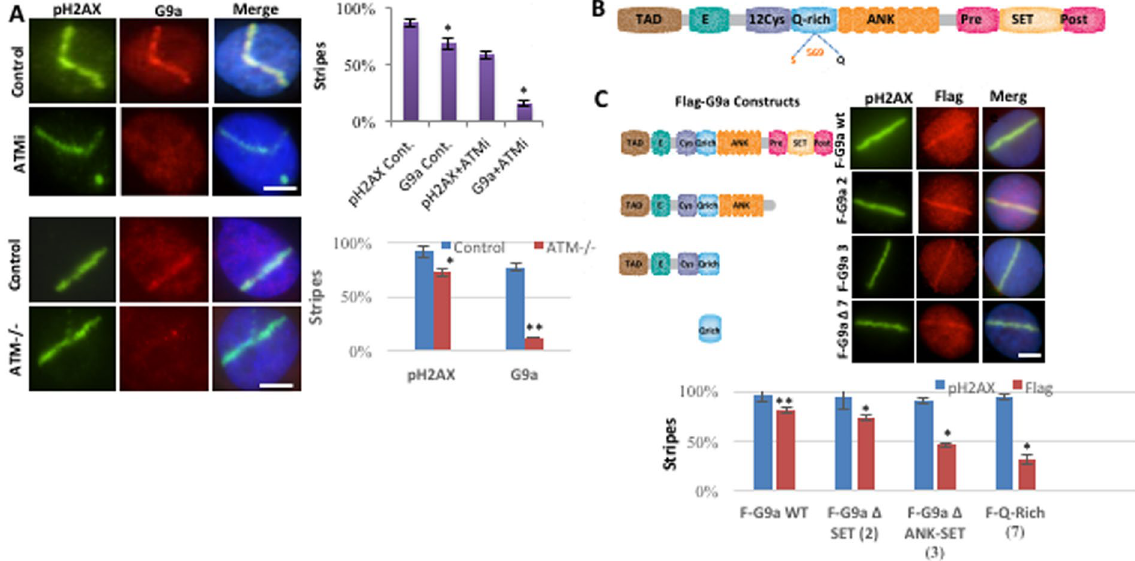
Figure 3. G9a localization is dependent upon ATM activation. ( A ) U2OS cells treated with ATMi, 0.5 uM overnight, or vehicle (Top panels) and ATM − / − and ATM + / + human fibroblast cells (bottom panels) cells were subjected to micro-irradiation and processed for IF using indicated antibodies. ( B ) Schematic representation of the domains of G9a protein. ( C ) U2OS cells stably expressing Flag-G9a deletion constructs were treated with micro-irradiation, and localization at DNA breaks are shown and quantified as indicated. Data are expressed as the mean ± SEM of at least three experiments. ** P < 0.01, * P < 0.05. Scale bar, 5 μ